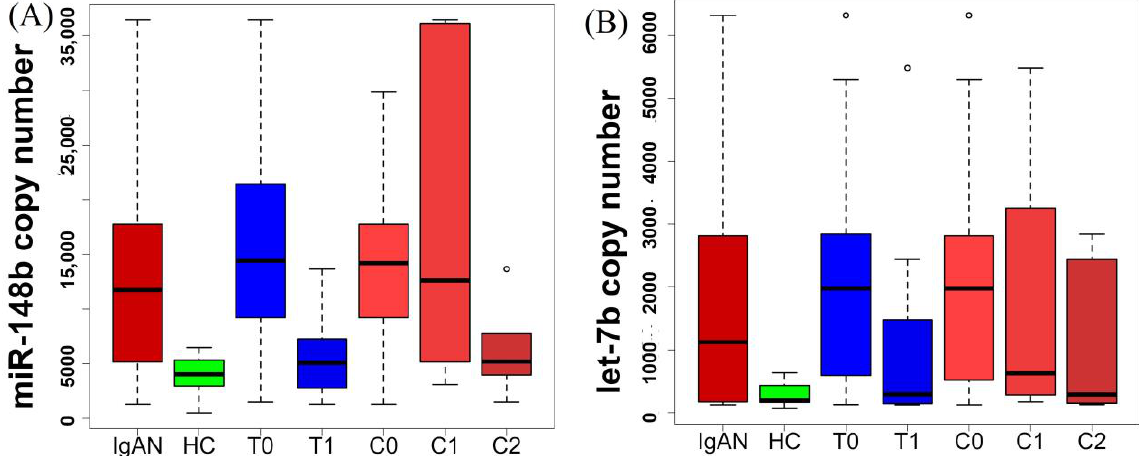
Figure 1. microRNA expression pattern with respect to histopathological stages in IgA nephropa- thy. IgAN: IgA nephropathy; HC: healthy control, microRNA concentration is expressed in copy number/ µ L RNA (isolated RNA eluted in 20 µ L nuclease-free water); T0, T1, C0, C1, and C2 are kidney biopsy interpretation score of MEST-C Oxford scoring system for the IgAN. ( A ): miR-148b expression (copy number) with respect to histopathological stages in IgA nephropathy. ( B ): let-7b expression (copy number) with respect to histopathological stages in IgA nephropathy.